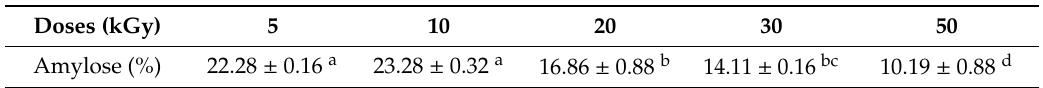
Table 2. Corn amylase content after EBI treatment.